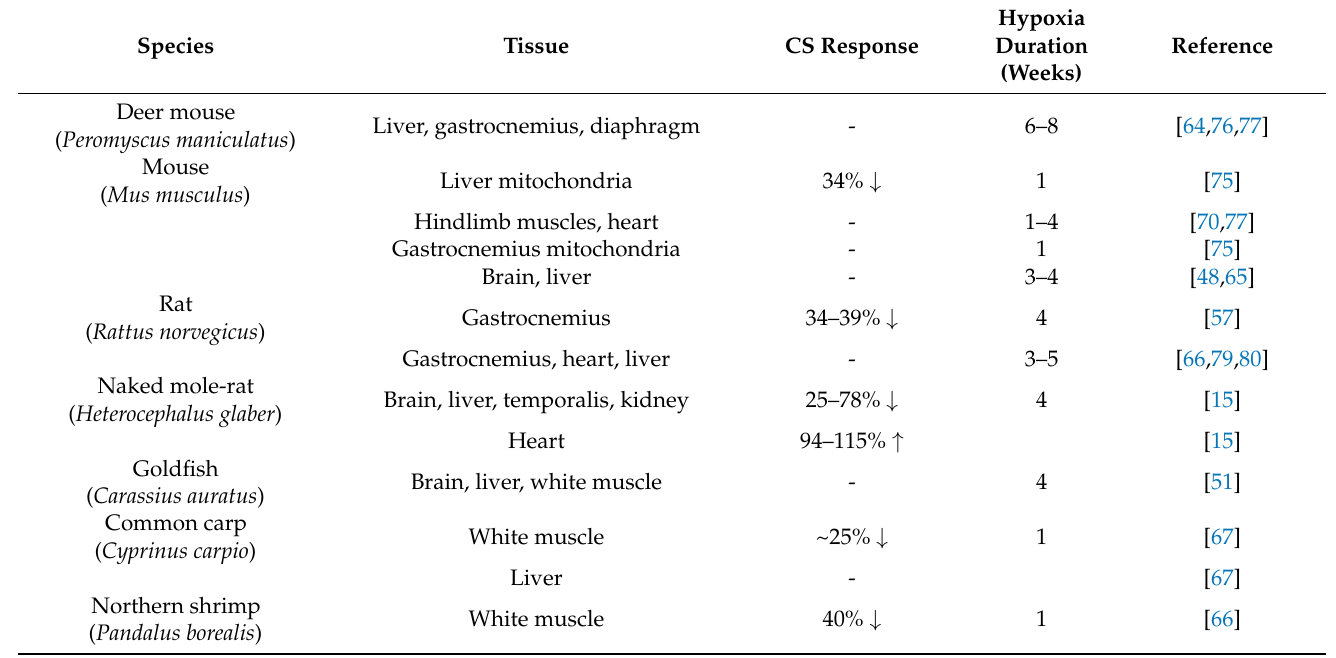
Table 8. Effects of chronic hypoxia (minimum 1 week) on the maximal activity of citrate synthase (CS) in various animals.